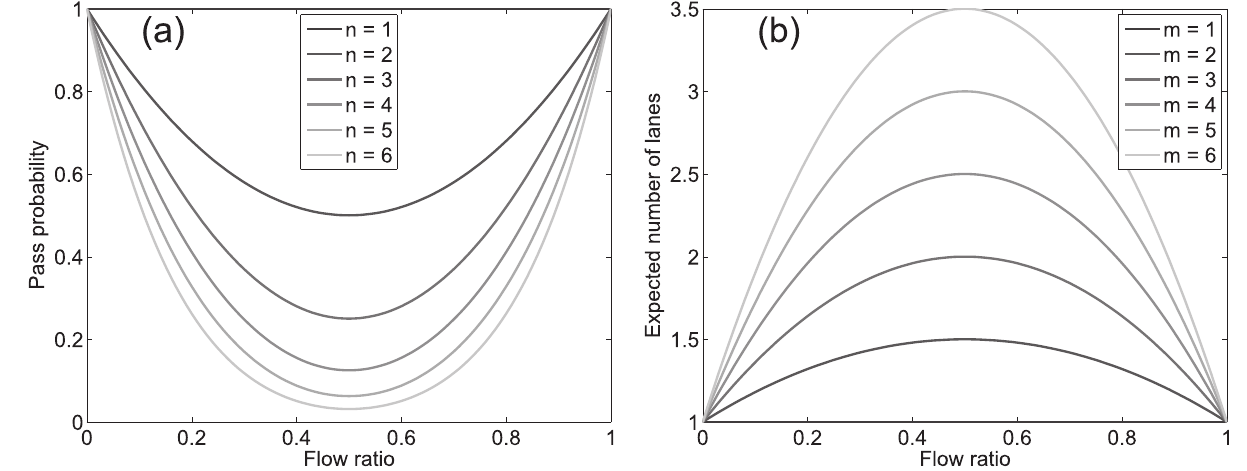
Fig 14. Open path probability and expected number of lanes. Different grid sizes are considered.